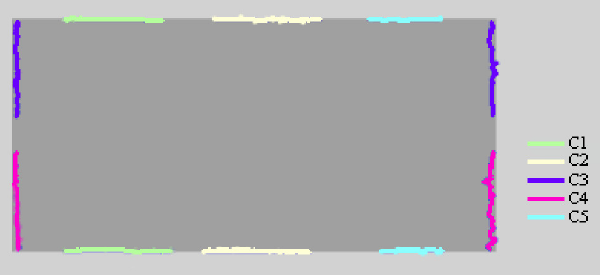
Figure 12. All the edge points are converted to the M-array coordinate system.